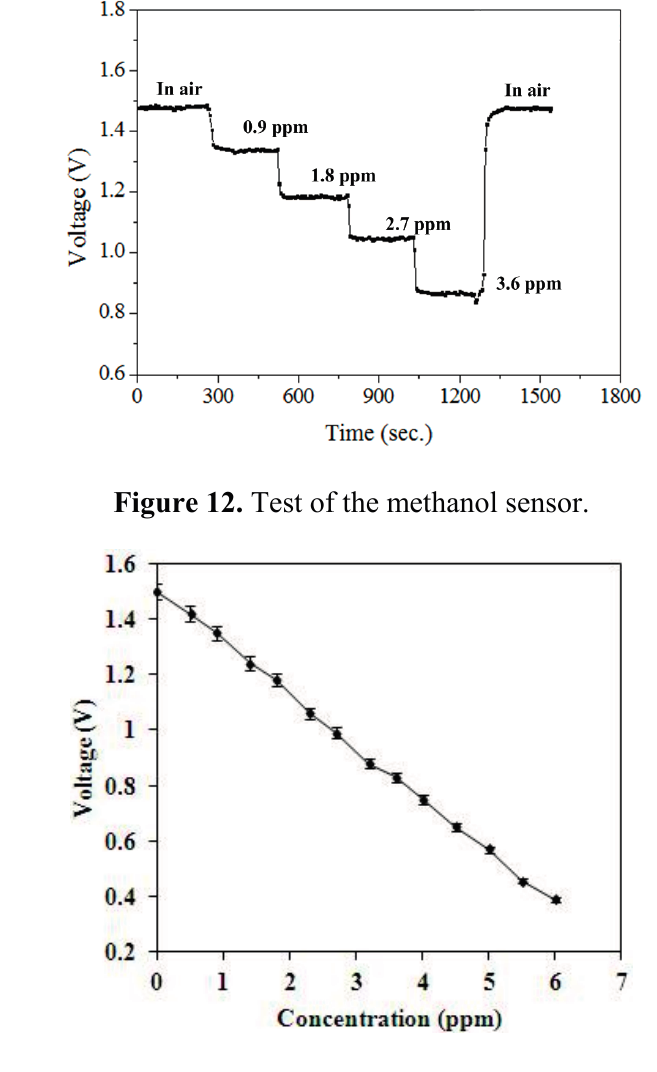
Figure 13. Measured output voltage of the methanol